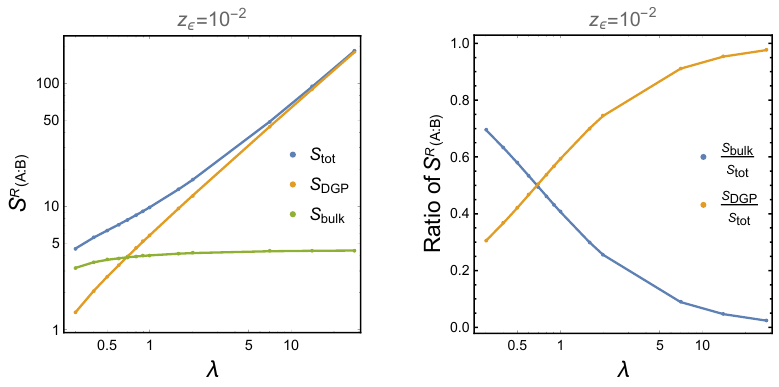
Figure 9 . The reflected entropy S R ( A : B ) and the contributions from each component [ S R ( A : B )] DGP and [ S R ( A : B )] bulk for different λ , where the UV cut-off is r (cid:15) =